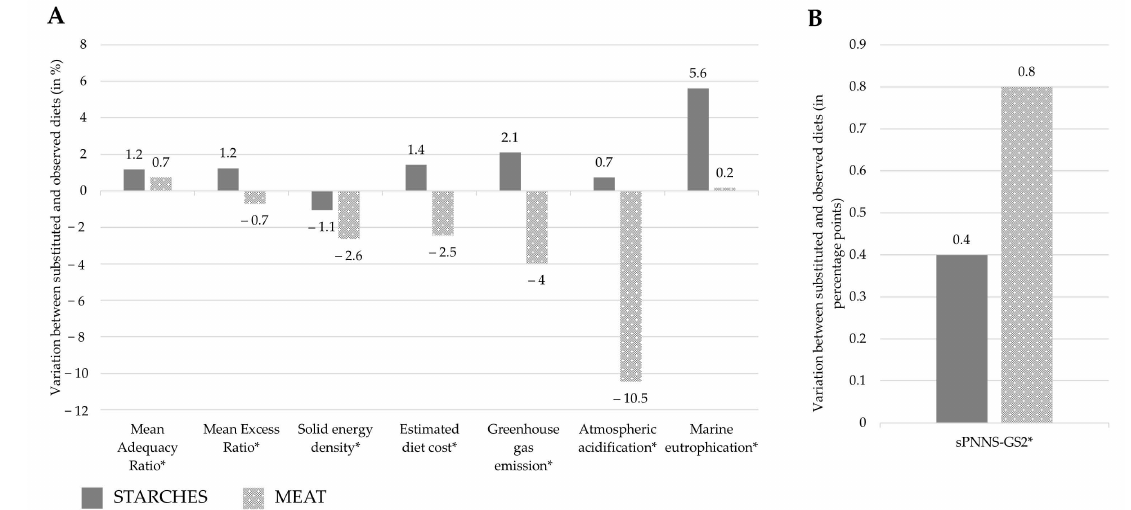
Figure 2. Variation in % of nutritional quality, estimated diet cost and environmental indicators (panel A ) and in percentage points for sPNNS-GS2 (panel B ) between diets obtained with the STARCHES scenario (iso-portion replacement of starches with pulses until the French recommended guideline for pulses is reached) or with the MEAT scenario (iso-portion replacement of meat with pulses until the French recommended guideline for pulses is reached) and the observed InAdeq diets (observed diets not reaching the recommended guideline for pulses, i.e., 57 g/day) ( n = 1853). Values are means adjusted for energy intake. sPNNS-GS2, simplified Programme National Nutrition Sant é Guideline Score 2. *: indication of a significant difference ( p value < 0.05) between diets obtained with the STARCHES or MEAT scenarios and observed InAdeq diets, after adjusting on the energy content of